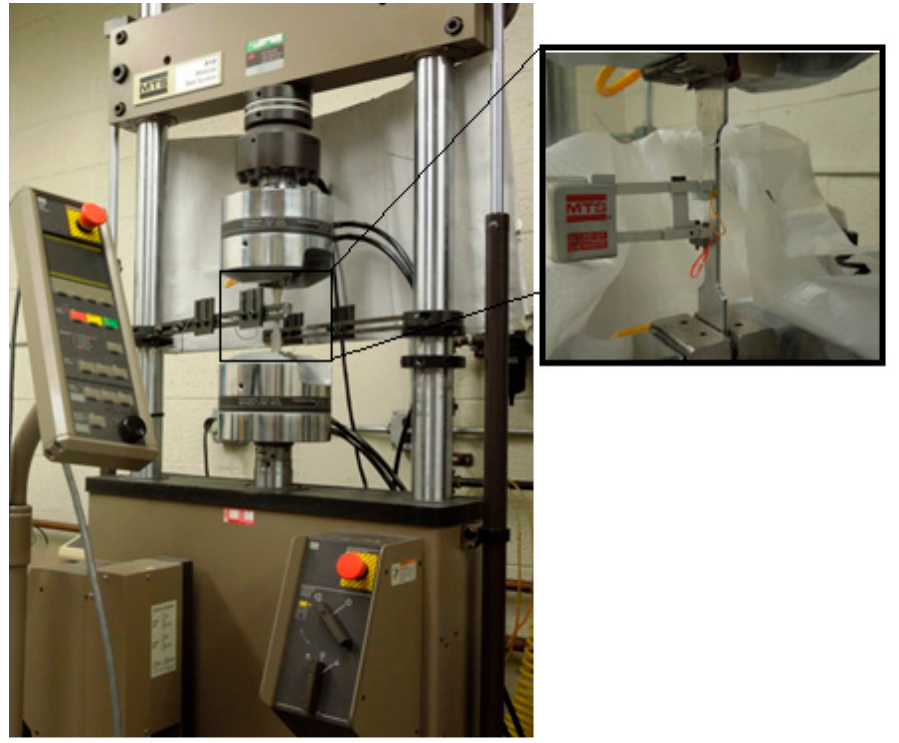
Figure 6. Dog bone specimen during tensile test.